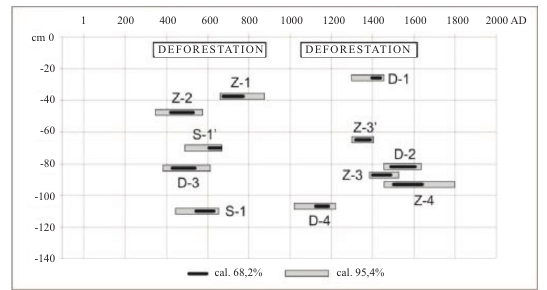
Fig. 6. Phases of deforestation distinguished on the basis of sedi­ ment age (calibrated dates); depth of dated material deposits